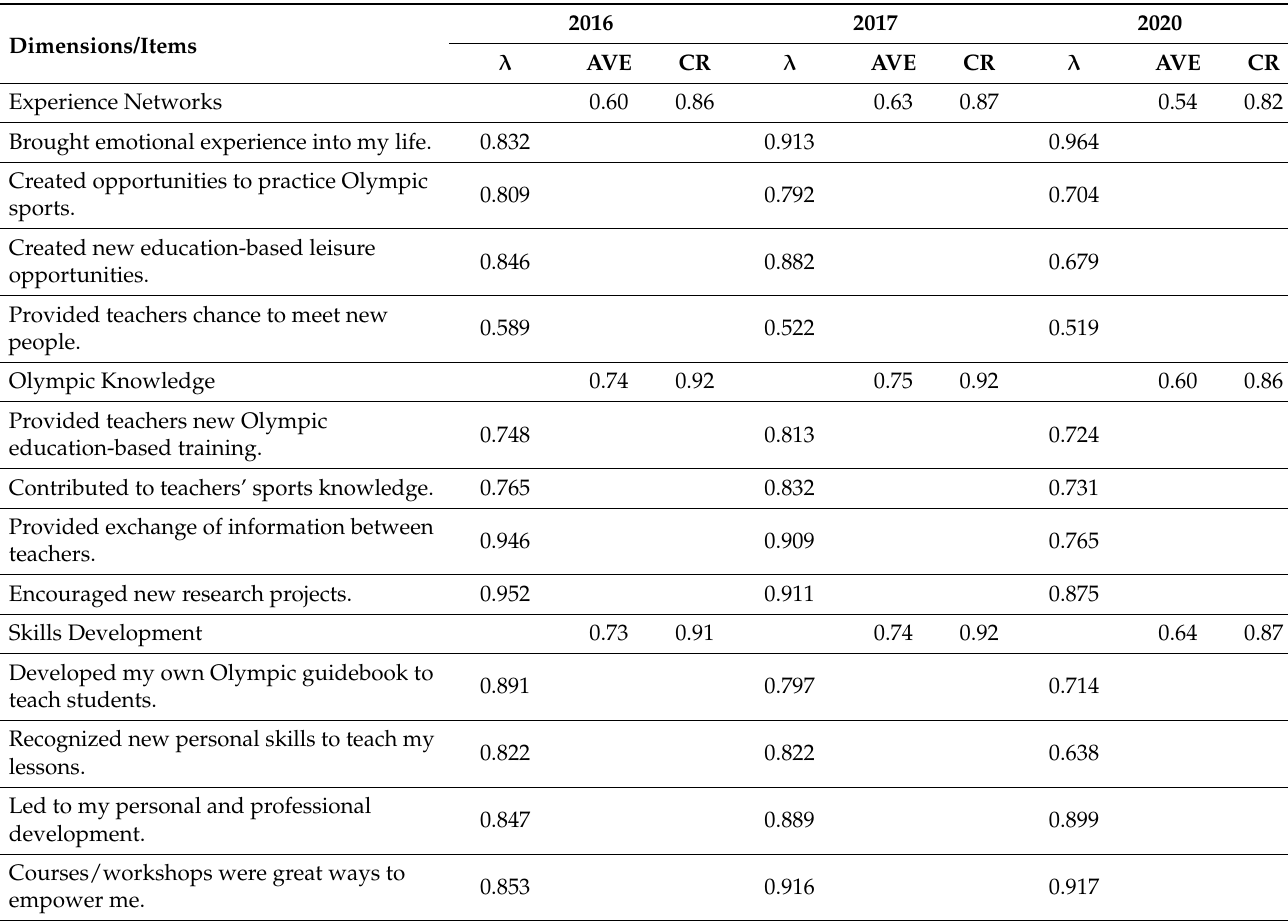
Table A1. Item wordings, factor loadings ( λ ), average variance explained (AVE), and composite reliabilities